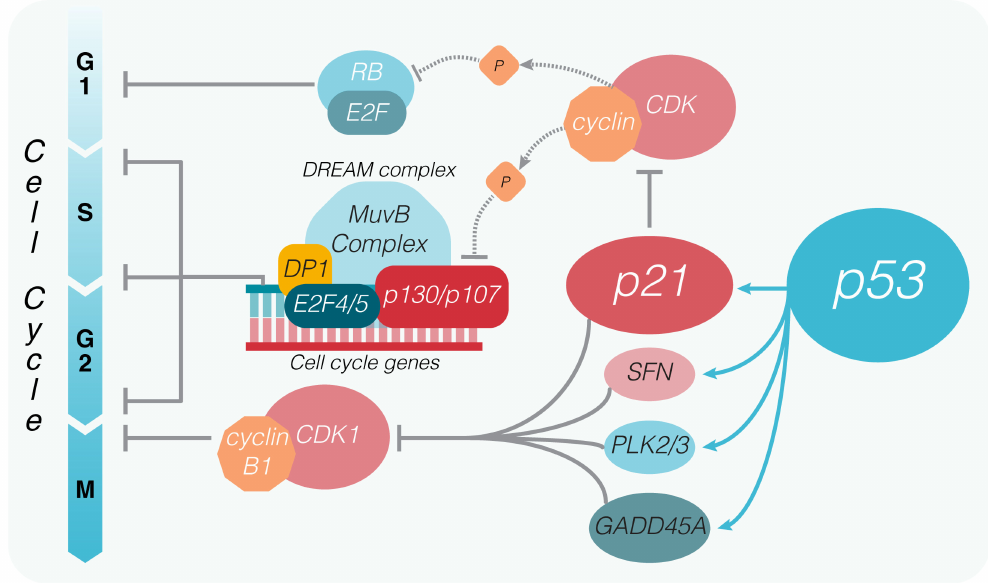
Figure 2. Cell cycle arrest imposed by p53. P53 controls the cell cycle via different routes by promoting the transcription of multiple targets, among which there are p21, SFN (14-3-3- σ ), GADD45A and the Polo like kinases (PLK) 2 and 3. The latter proteins contribute to the inhibition of the Cyclin- dependent kinase 1 (CDK1), which upon binding to cyclin B1 promotes mitotic entry. P21 inhibits the formation of cyclinE/A-CDK2 and cyclinD-CDK4/6 complexes, which control the entry into the S phase by phosphorylating the retinoblastoma (pRB) protein. The p21-dependent inhibition of cyclin- CDK complexes also results in hyperphosphorylation of the retinoblastoma related pocket proteins p130/p107, keeping the DREAM complex in its inhibitory state, thus preventing the expression of multiple other genes responsible for cell cycle